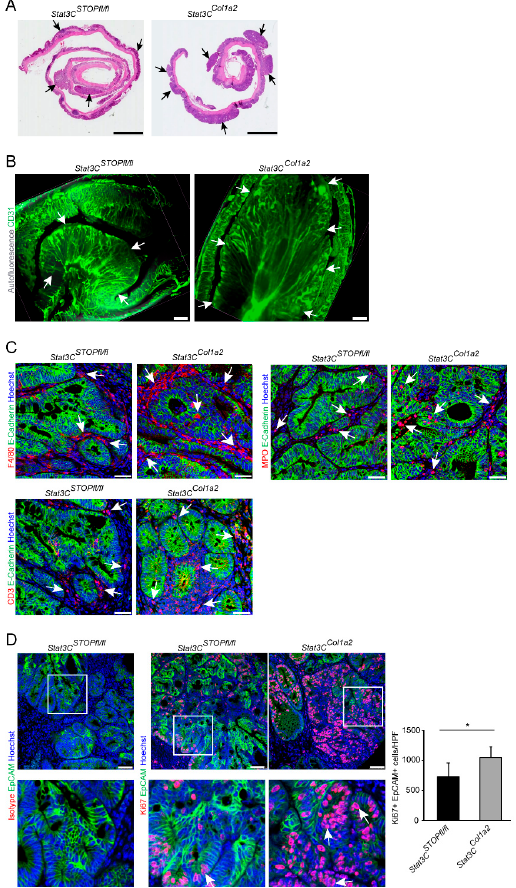
Figure 3. Constitutive activation of STAT3 in type I collagen-expressing fibroblasts increases tumor cell proliferation. ( A ) Colon tissue with tumors from AOM/DSS-treated Stat3C Col1a2 mice and littermate controls was prepared as Swiss rolls, stained by H&E and analyzed by microscopy. Arrows indicate tumors. Scale bar: 2500 µm. ( B ) Colon tumors of the AOM/DSS model from Stat3C Col1a2 mice and littermate controls were stained with a fluorescently labeled anti-CD31 antibody (green) and visualized by light sheet fluorescence microscopy. Autofluorescence is shown in grey. Arrows highlight tumors. Scale bar: 500 µm. ( C ) AOM/DSS tumors were harvested from Stat3C Col1a2 mice and Stat3C STOPfl/fl controls at day 64 and analyzed by immunofluorescence staining for immune cells (F4/80+, MPO+ or CD3+) and E-Cadherin as indicated. Arrows indicate infiltrating cells. Scale bar: 50 µm. ( D ) AOM/DSS tumor tissue (day 64 from Stat3C Col1a2 mice and Stat3C STOPfl/fl controls ( n = 4–7/group) was immunofluorescently co-stained for Ki67 and EpCAM and analyzed by confocal microscopy. For each sample, 45 representative HPFs were scored. Arrows highlight Ki67+EpCAM+ tumor cells. Scale bar: 50 µm. The results are representative of at least two independent experiments. Quantitative data are shown as mean values ±SD. Significant differences are indicated (* p < 0.05)).